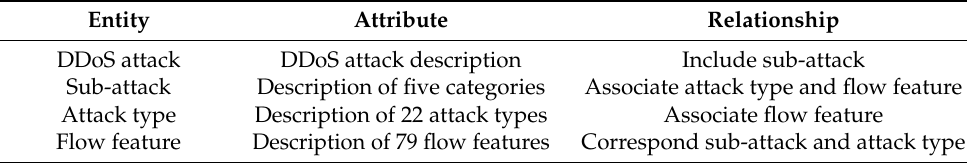
Table 4. Triples of malicious behavior feature graph.